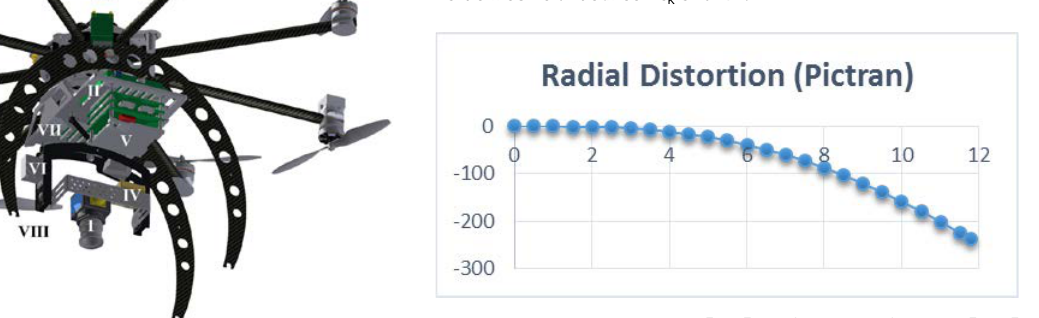
Figure 4: Radial Distortion [µm] as function of radius [mm] (APO Xenoplan). Software used: Technet